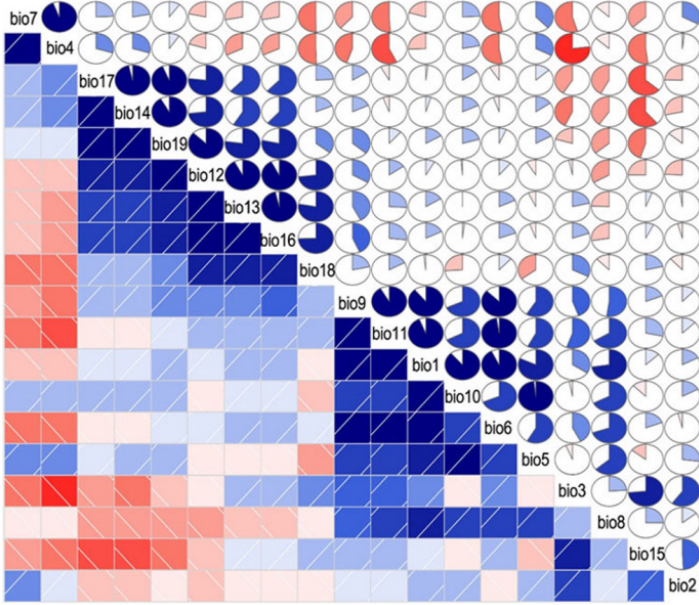
Figure 2. Correlations among 19 climatic variables. The blue color in the lower triangular cell and